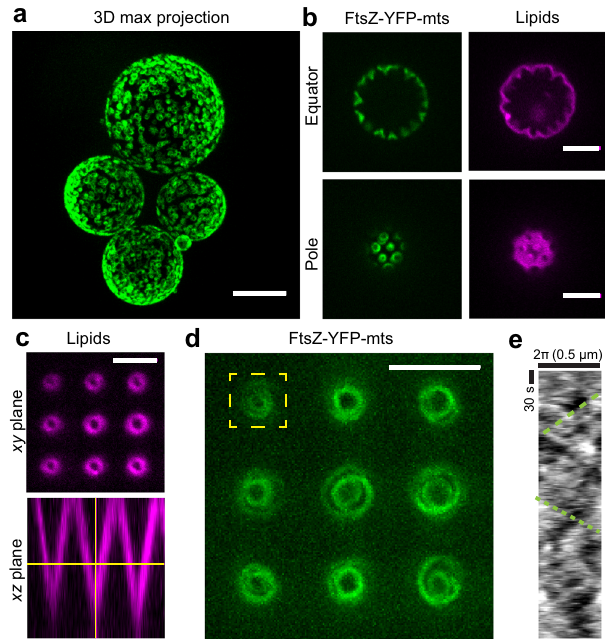
Fig. 1 Bidirectional FtsZ treadmilling rings yield directional screw-like lipid membrane deformations. a FtsZ-YFP-mts ring structures externally decorating GUVs (scale bar = 10 µ m). b After GUV de fl ation, inwards conical deformations emerged from FtsZ rings (GUVs: N > 20) (scale bar = 5 µ m). c Inspired by deformations in ( b ), we designed a PDMS microstructure with inwards conical geometry covered with a supported lipid bilayer (SLB). The imaging plane was chosen to have a cross-section of 1 – 2- µ m diameter (scale bar = 5 µ m). d Inside cones, FtsZ-YFP-mts self- assembled into dynamic vortices (Supplementary Movie S1) (scale bar = 5 µ m). e A representative kymograph ( N > 3) showed negative and positive slopes indicating the presence of clockwise and anticlockwise